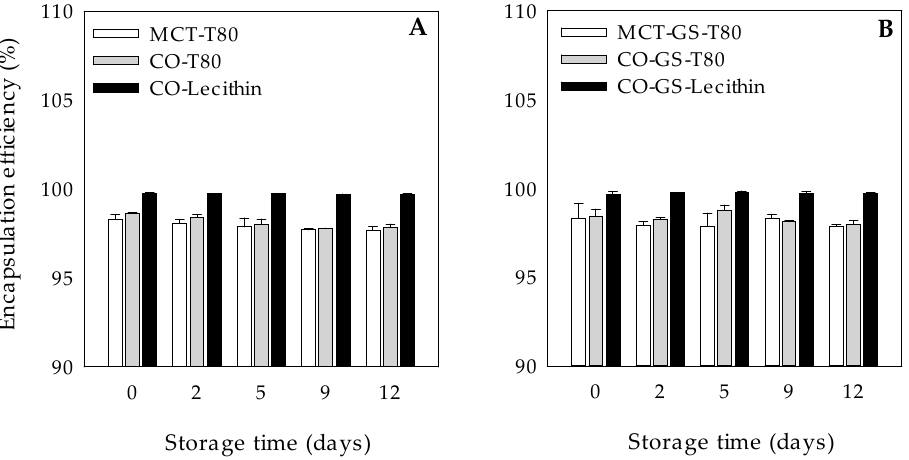
Figure 5. Encapsulation efficiency (%) during 12 days of dark storage at 4 ◦ C of chlororphyllin-loaded W 1 /O/W 2 emulsions formulated with different lipid phases consisting on medium chain triglyceride (MCT) or corn oil (CO) and without ( A ) or with ( B ) glyceryl stearate (GS) as well as different hydrophilic surfactants (Tween 80 (T80) or Lecithin).